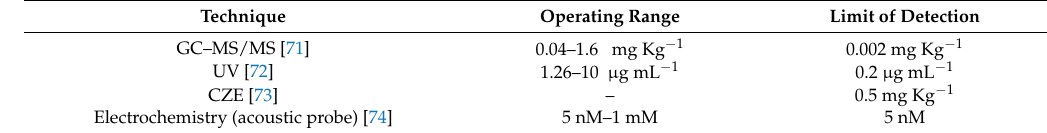
Figure S1: CV for the electropolymerization MIP on Au surface. Scan rate: 5 mV/s; number of scans: 150; potential range: − 0.4 to 1.3